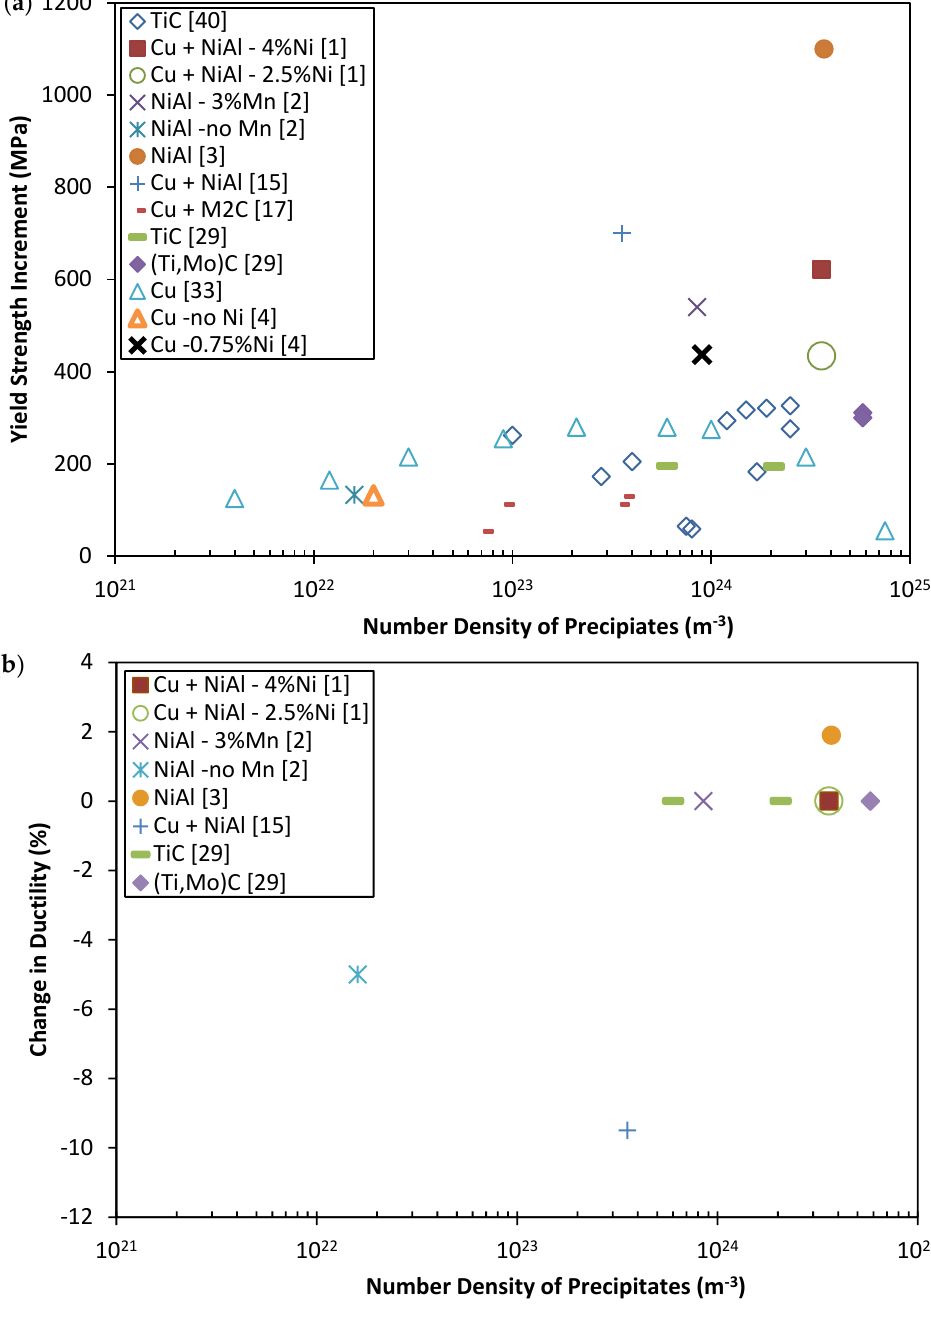
Figure 2. A compilation of ( a ) yield strength increment and ( b ) ductility change against precipitate number density of various precipitate strengthened steels.